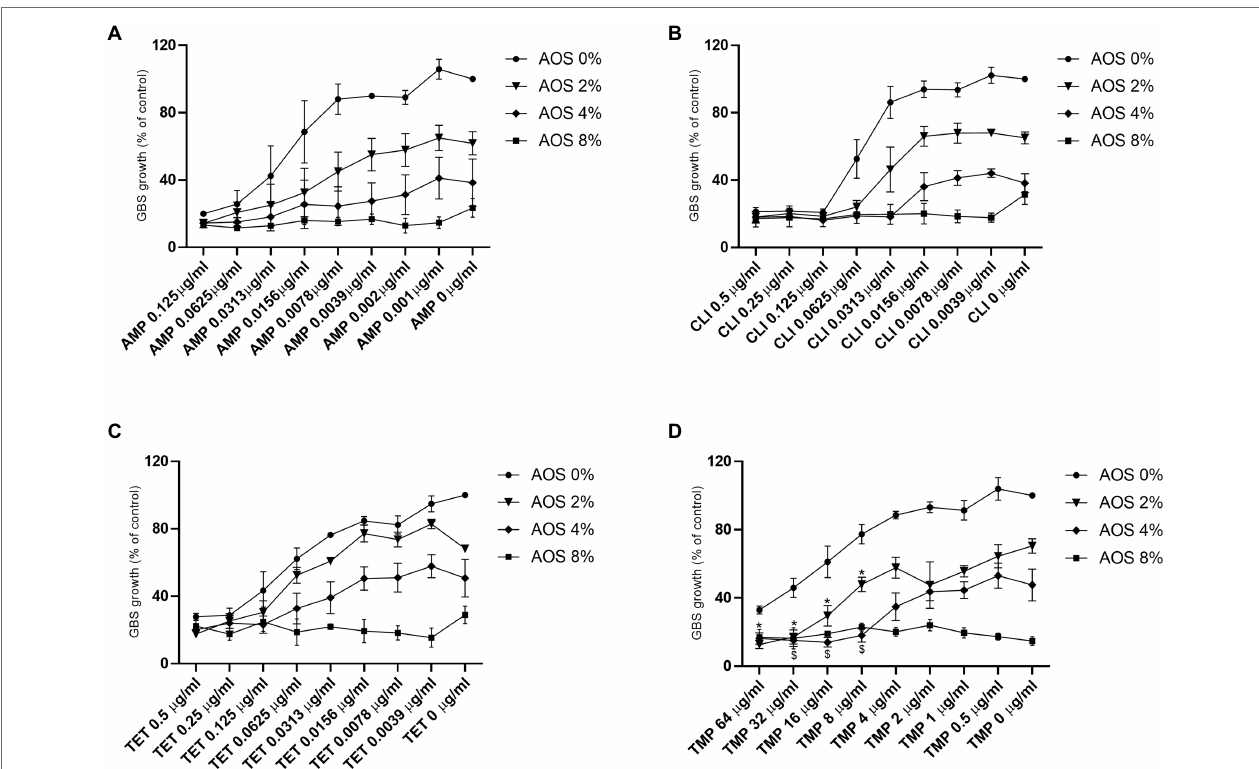
FIGURE 3 | Effect of AOS in combination with AMP, CLI, TET and TMP on the growth of GBS V strain. To examine whether AOS has the feasibility to sensitize GBS V to antibiotics, a sensitization assay was performed as described in the material and method section. AOS (2, 4 and 8%) were combined with different concentrations of AMP (A) , CLI (B) , TET (C) and TMP (D) . Sensitization was only achieved when 2 and 4% AOS were combined with TMP. Star (for 2% AOS) or dollar (for 4% AOS) are representing a significant reduction of the combinational treatments comparing with both corresponding antimicrobial agents (AOS and antibiotics). Positive control represents the percentage of the absolute growth of bacteria (100% growth) without the presence of any treatment. The results are expressed as the percentage of bacterial growth as mean ± SEM of three independent experiments each performed in a minimum of three replicates. Statistical differences *, $ ( p < 0.05) compared to control and the corresponding concentrations of antibiotics and AOS, were obtained using a two-way ANOVA